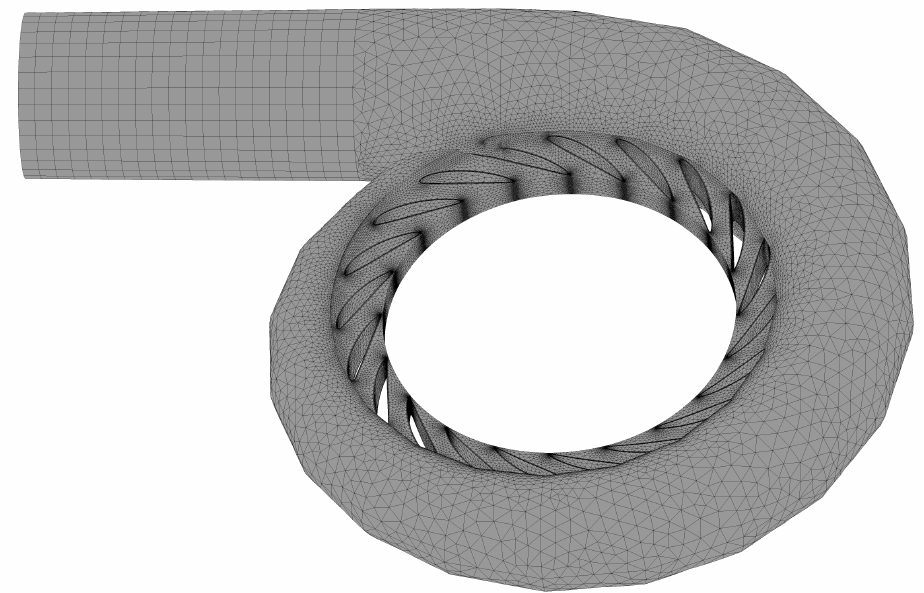
Figure 4. Mesh of the spiral case and stay vanes domains.